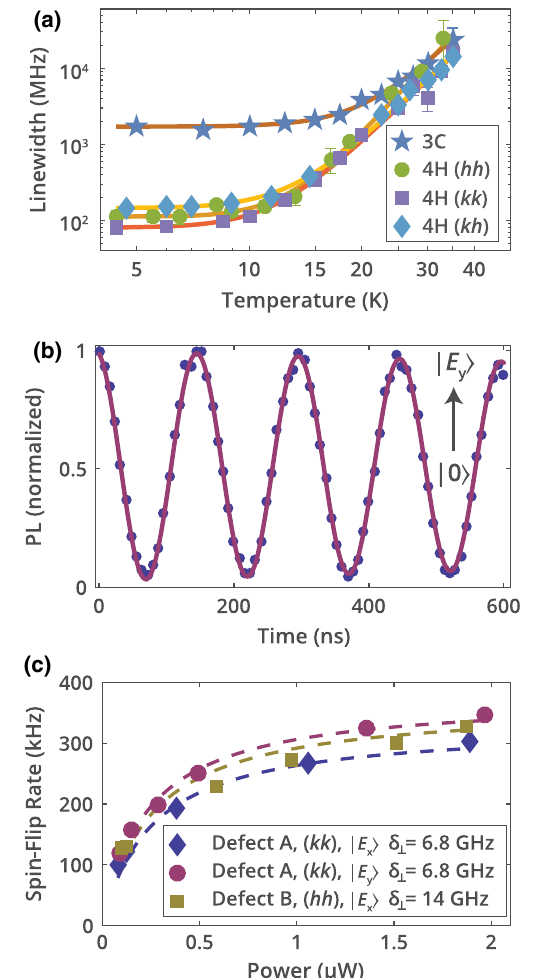
FIG. 3. Characterization of divacancy optical transition proper- ties. (a) Temperature dependence of the optical linewidths of different inequivalent 3C-SiC and 4H-SiC divacancy defects. (b) Single-spin Rabi oscillations recorded using the E single 4H-SiC ( hh ) divacancy at T ¼ 8 K and B ¼ 15 G with a transverse strain of δ ⊥ ¼ 27 GHz. The measurement gives a background-corrected readout contrast of 94%, consistent with a high degree of spin polarization. (c) The spin-flip rate as a function of resonant laser power measured on different E transitions on different single 4H-SiC